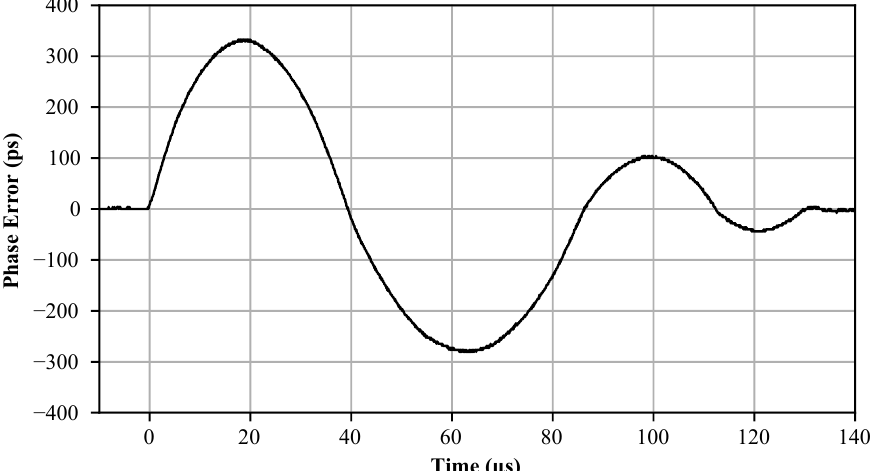
Figure 11. Example SEE phase transient stimulated by high LET (62.5MeVcm 2 mg −1 ) ions. The parabolic phase response characteristic for Bang-Bang PLLs is observed. The loop transitions back to the random noise regime after